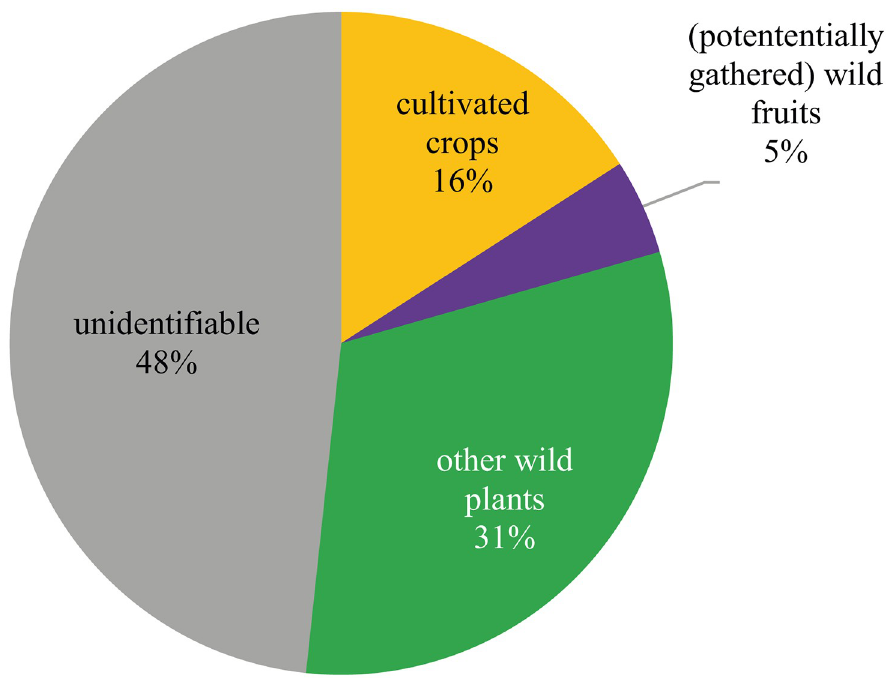
Fig 10. Overall composition of the Late Bronze Age charred archaeobotanical find assemblage at Prigglitz- Gasteil. n = 7,022. Diagram: OeAW-OeAI/T. Jakobitsch.